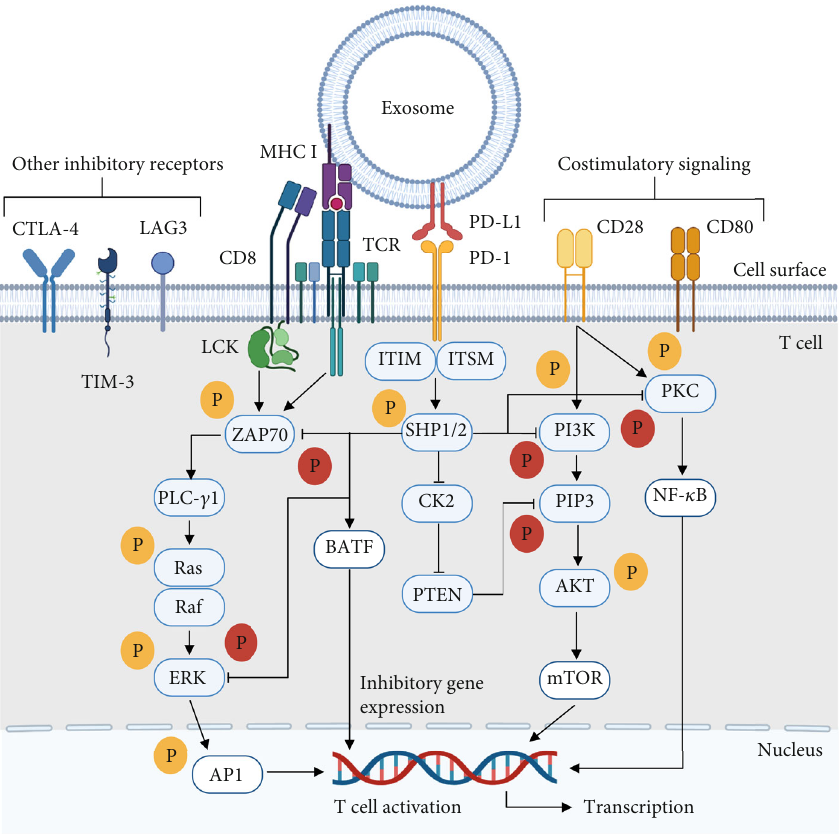
Figure 2: The proposed inhibitory signaling in T cells mediated by exosomal PD-L1. Upon antigen presentation, the T cell receptor (TCR) and costimulatory receptors CD8, CD28, and CD80 mediate the phosphorylation of intracellular mediators (blue boxes) of the PI3K/AKT/mTOR and MAPK signaling pathways which results in the activation of transcription factors (white boxes) that induce T cell activation. Upon binding of exosomal PD-L1 to PD-1, SHP-1 and SHP-2 protein tyrosine phosphatases prevent the phosphorylation of PKC, PI3K, ZAP70, and ERK, thereby inhibiting T cell e ff ector function. SHP-1/SHP-2 also inhibits CK2, allowing phosphatase and tensin homolog (PTEN) to prevent PIP3 phosphorylation. SHP-1/SHP-2 are also proposed to mediate inhibitory gene expression via basic leucine zipper ATF-like transcription factor (BATF). Other inhibitory receptors also mediate T cell dysfunction in the context of tumor immune